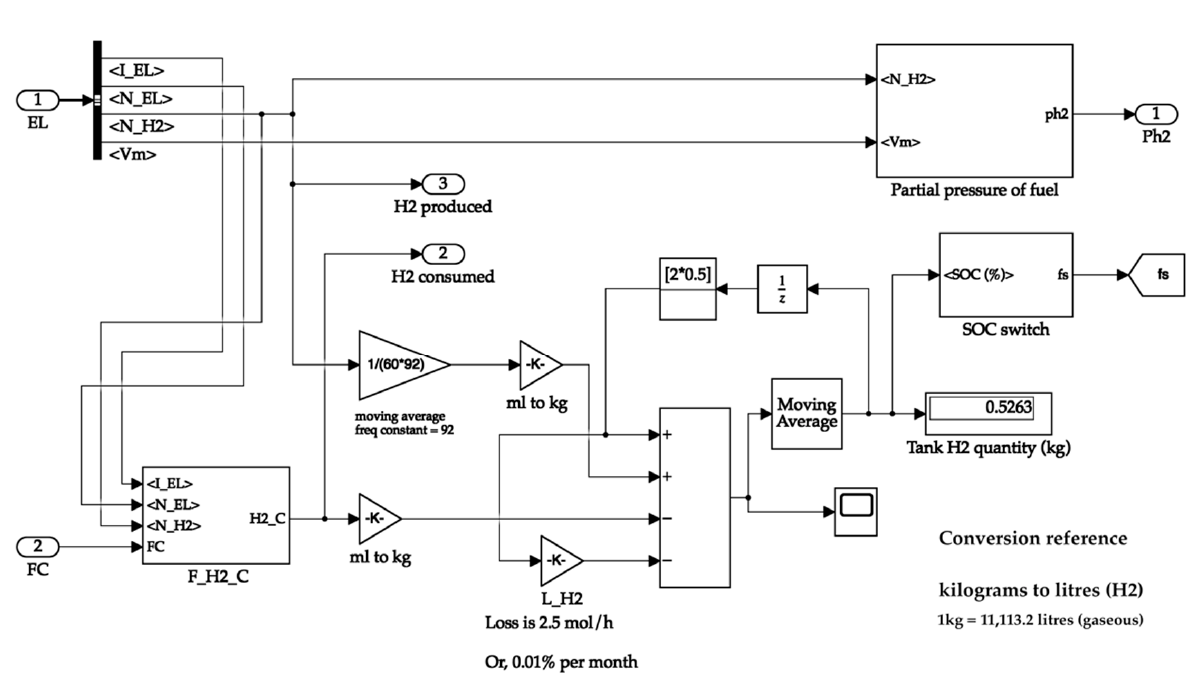
Figure 9. Hydrogen storage